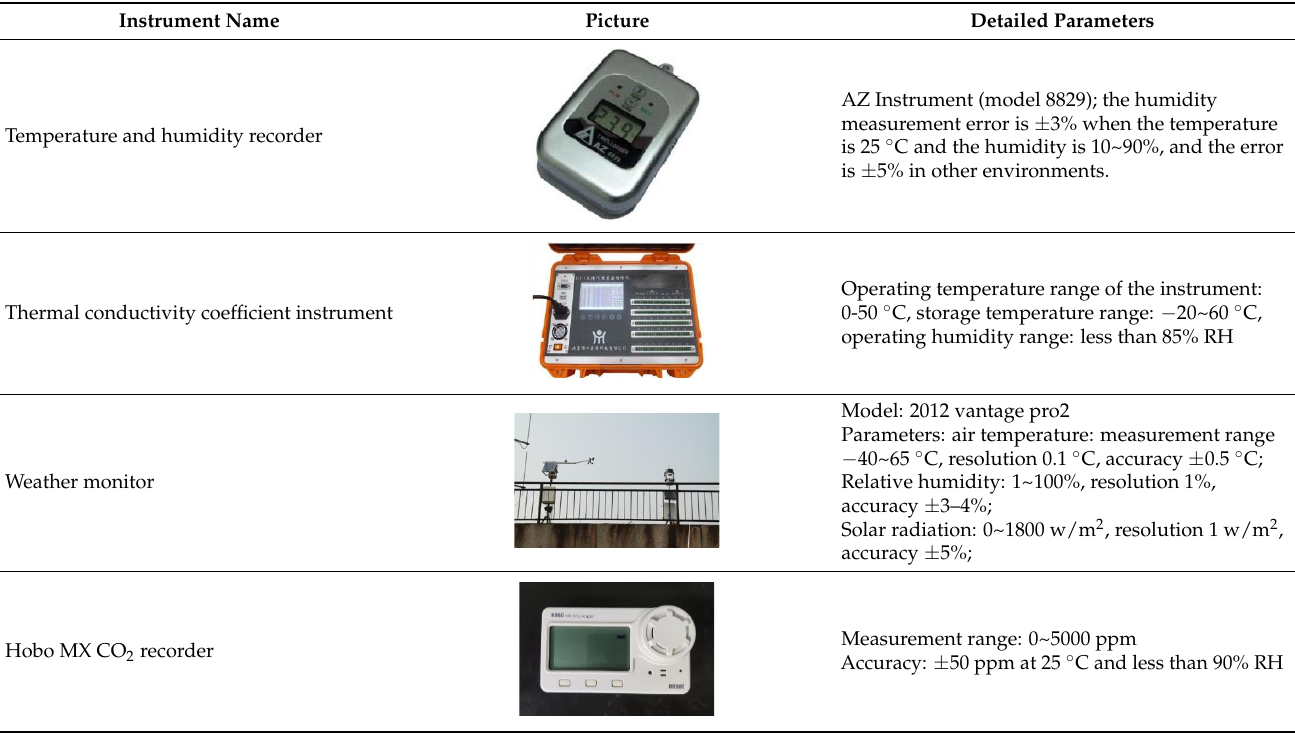
Table 5. List of experimental instruments.